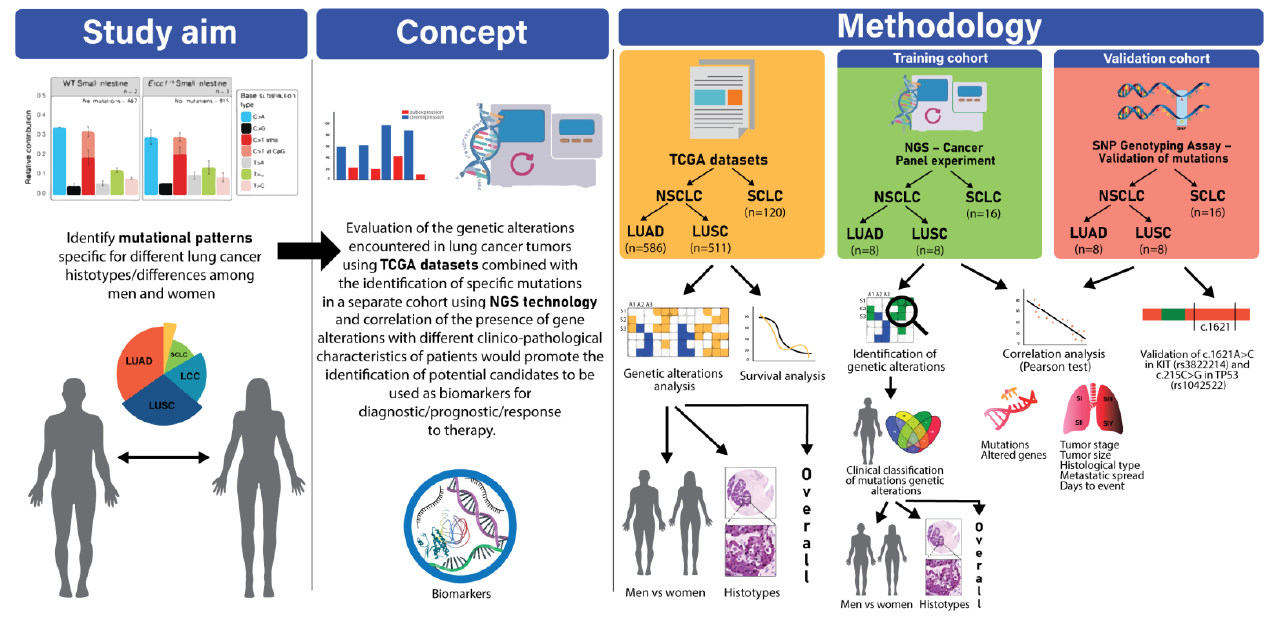
Figure 1. Flowchart of the study design.